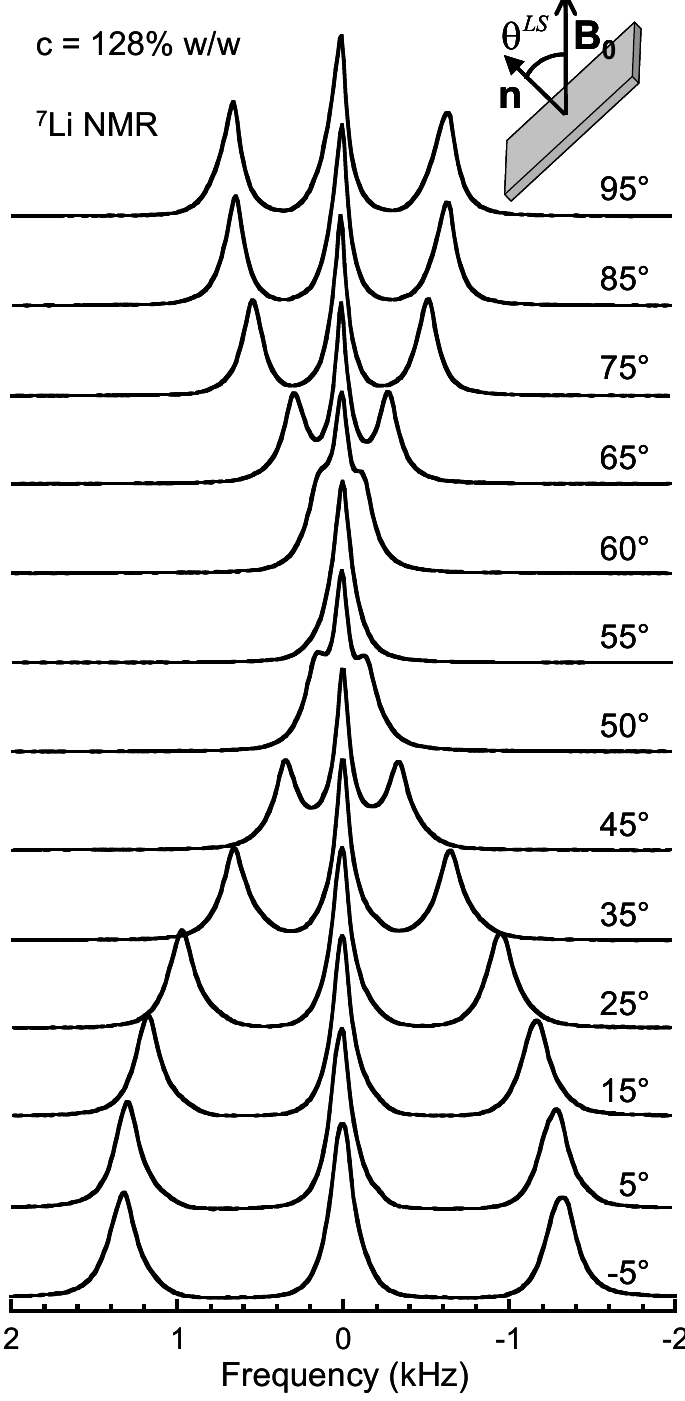
Figure 10. Variation of the 7 Li NMR spectra measured within laponite aqueous dispersion as a function of the orientation of the clay sample in the static magnetic field. Reprinted with permission from Ref. [10]. Copyright (2008) American Chemical